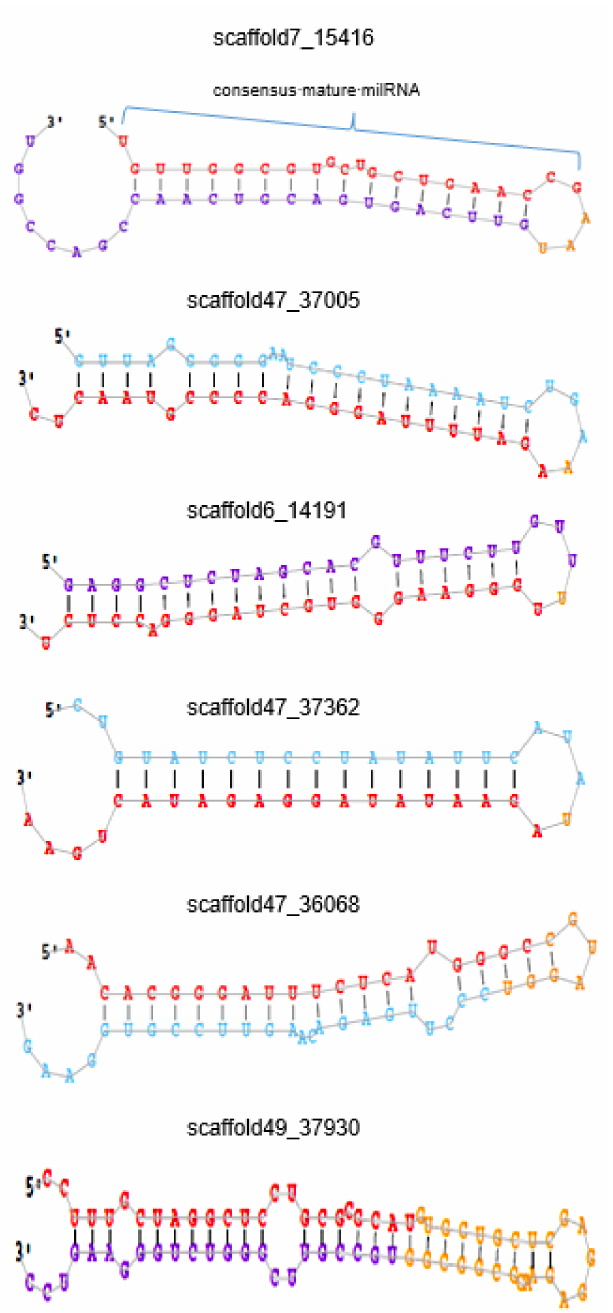
Figure 1. Depiction of representative novel milRNAs identified in this study. Red colour nucleotides indicate the sequence of mature milRNAs. Blue, purple, and golden colours are the backbone of novel